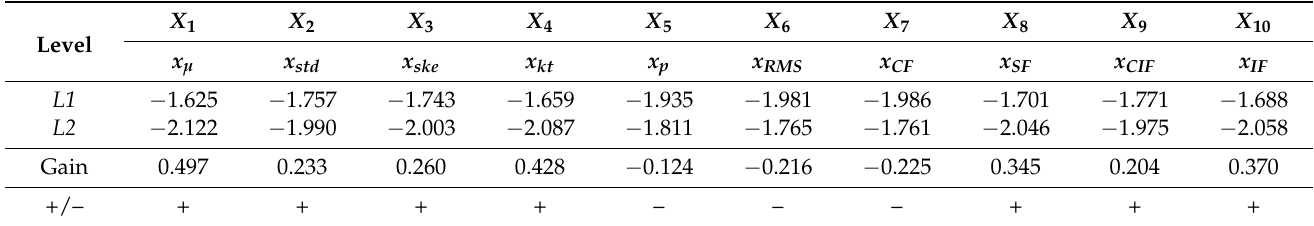
Table 8. Gain of SN ratio for each